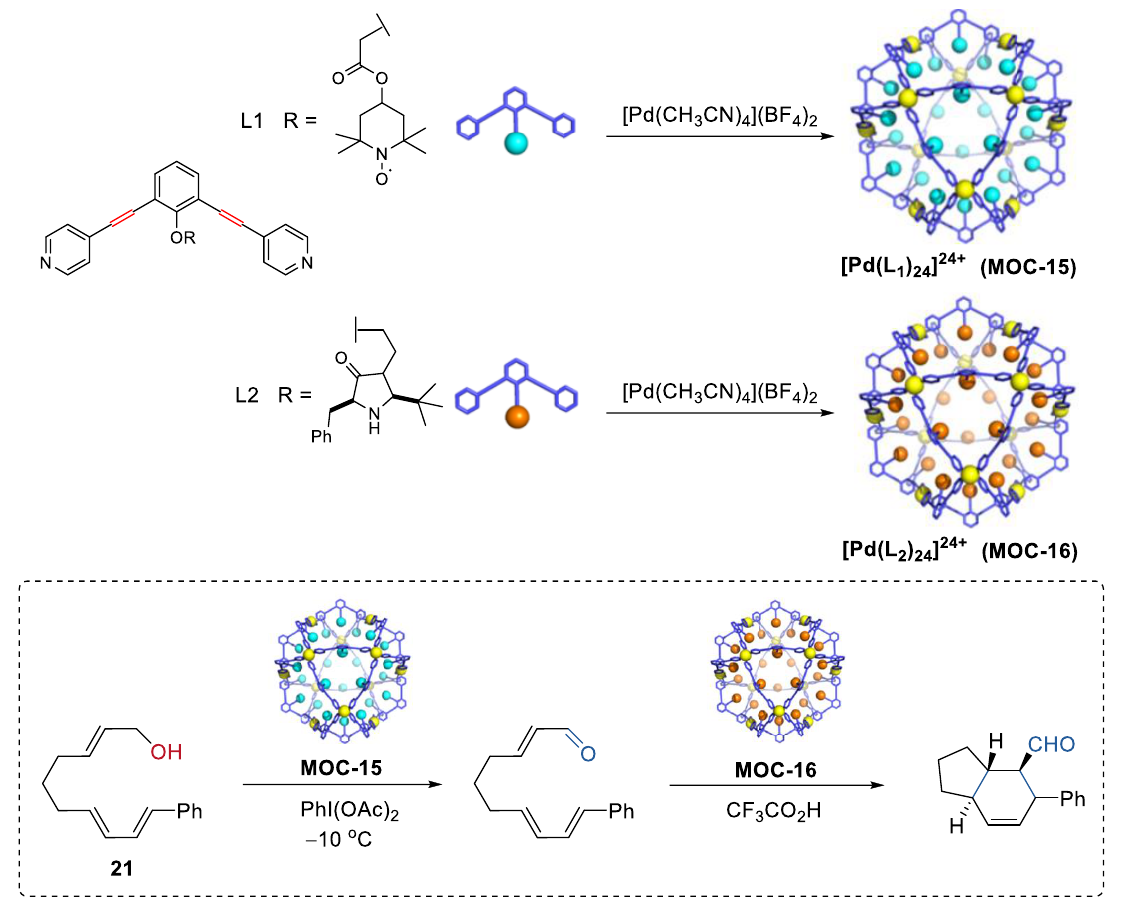
Figure 16. Oxidation of an alcohol followed by a stereoselective Diels−Alder cyclization catalyzed by MOC-15 and MOC-16 [83]. Reaction conditions: 21 (8.0 × 10 − 2 mmol), MOC-15 (10 mol%), MOC-16 (10 mol%), PhI(OAc) 2 (115 mol%), CF 3 COOH (10 mol%), CD 3 NO 2 /D 2 O, −10 °C. Reprinted/adapted with permission from Ref. [83]. Copyright 2017 American Chemical Society.